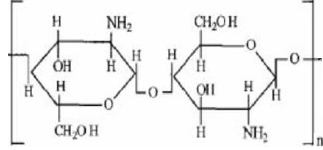
Figure 1. Structural illustration of